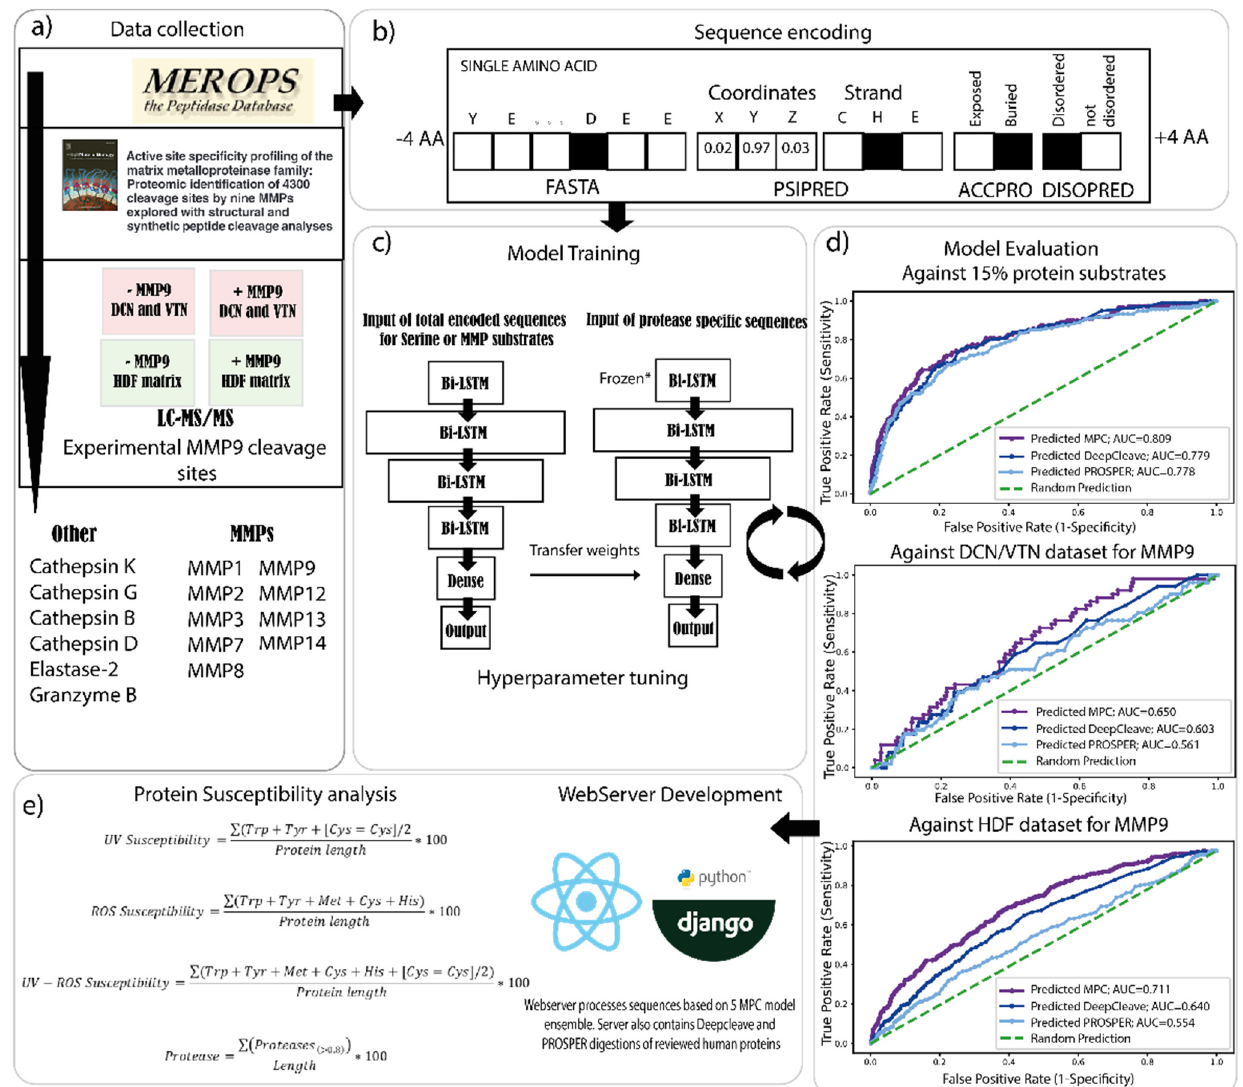
Figure 2. Manchester Proteome Cleave prediction model: architecture and testing. (a) We developed a novel protease prediction algorithm, the Manchester proteome cleave (MPC), based on state-of-the-art deep learning methodologies. The development of MPC involved five major steps: ( a ) data collection: integration of data from publicly available protease cleavage databases (MEROPs), the Eckhard 2016 dataset and our own in-house experiments. ( b ) Sequence encoding: MPC utilized primary AA sequence and structural features derived by in silico modeling with PSIPRED, DISOPRED and ACCPRO. One-hot encoding was used to represent the protein sequences in the format required for recurrent neural networks. ( c ) Model training: the MPC model consisted of 4 bidirectional long-short-term memory (Bi-LSTM) layers, one fully connected dense layer and an output layer. A general protease model was first pre-trained, and the resultant weights were transferred to train a protease-specific model. ( d ) Model evaluation: hyperparameters were tuned against 15% of excluded proteins and for MMP9, also against our experimental DCN/VTN and human dermal fibroblasts (HDF) cleavage site dataset utilizing a grid search strategy. ( e ) Webserver Development and Protein Susceptibility analysis: the best-performing architecture was used to train an additional four models, which were integrated into our MPSC web tool. Hence MPSC uses 5 models-averaged ensembles to infer the final cleavage scores for each of the proteases. MPSC web tool is also capable of performing UV and ROS assessments of proteins. The MPSC web server is publicly available on